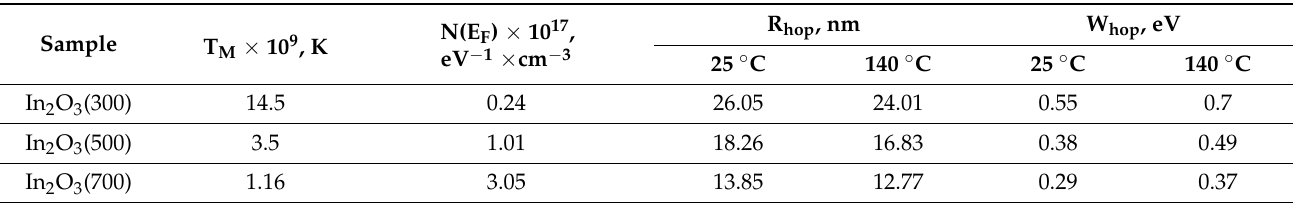
Table 4. Parameters characterizing the conductivity of the studied samples according to the Mott